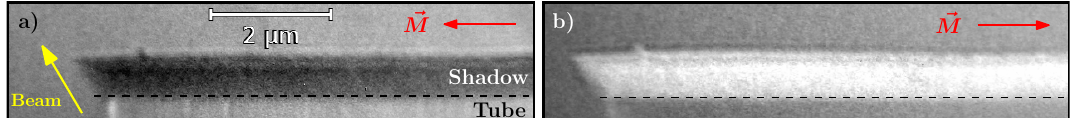
Table 1: Saturation magnetostriction λ